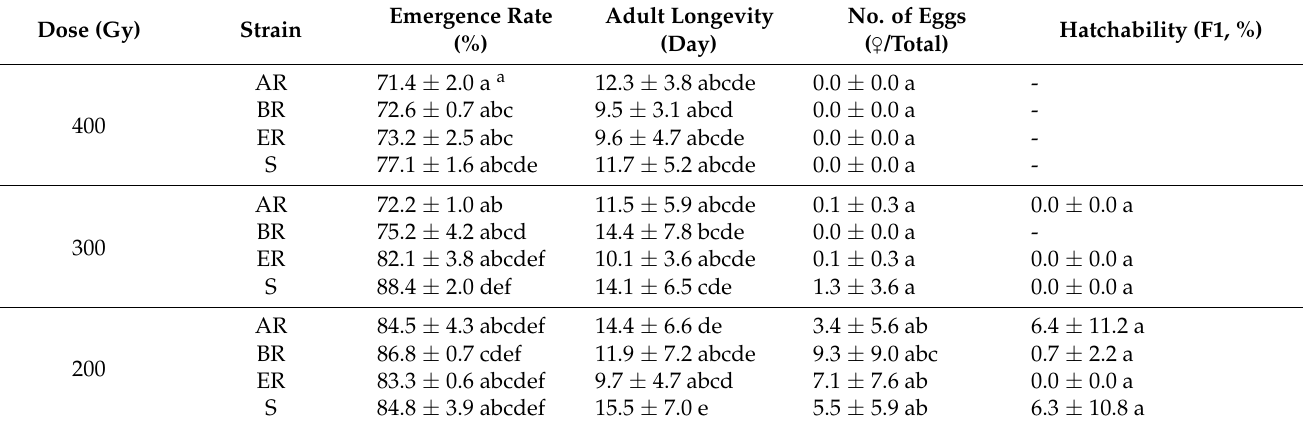
totally suppressed at 300 Gy. Table 3. Effect of electron beam irradiation on nymphs of the AR, BR, ER, and S strains of T. urticae . Dose